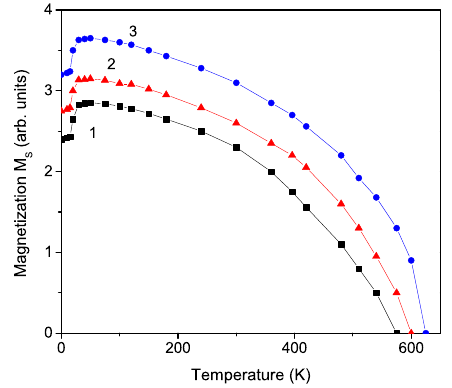
Figure 1. Temperature dependence of the magnetization M s in MFO for (1) bulk; and a NP with (2) N = 20 and (3) N = 10 shells, J s = 1.2 J b , D s = 20 D b .